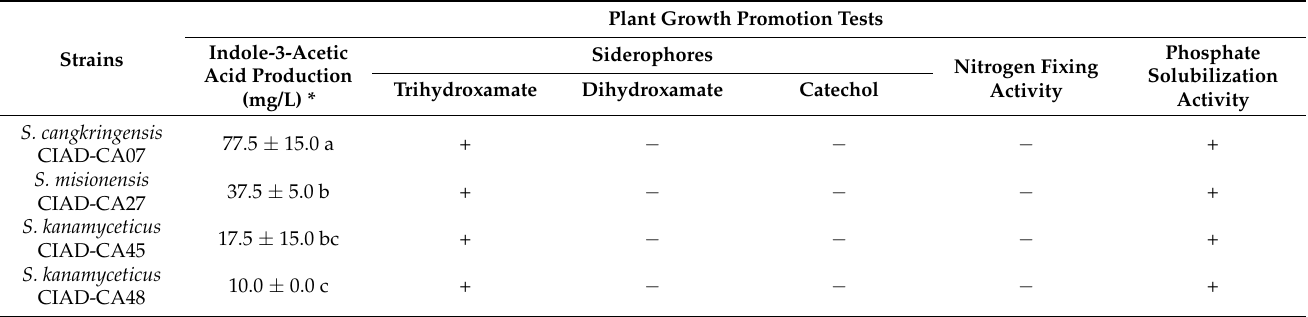
Table 1. Substances involved in plant growth promotion produced by Streptomyces